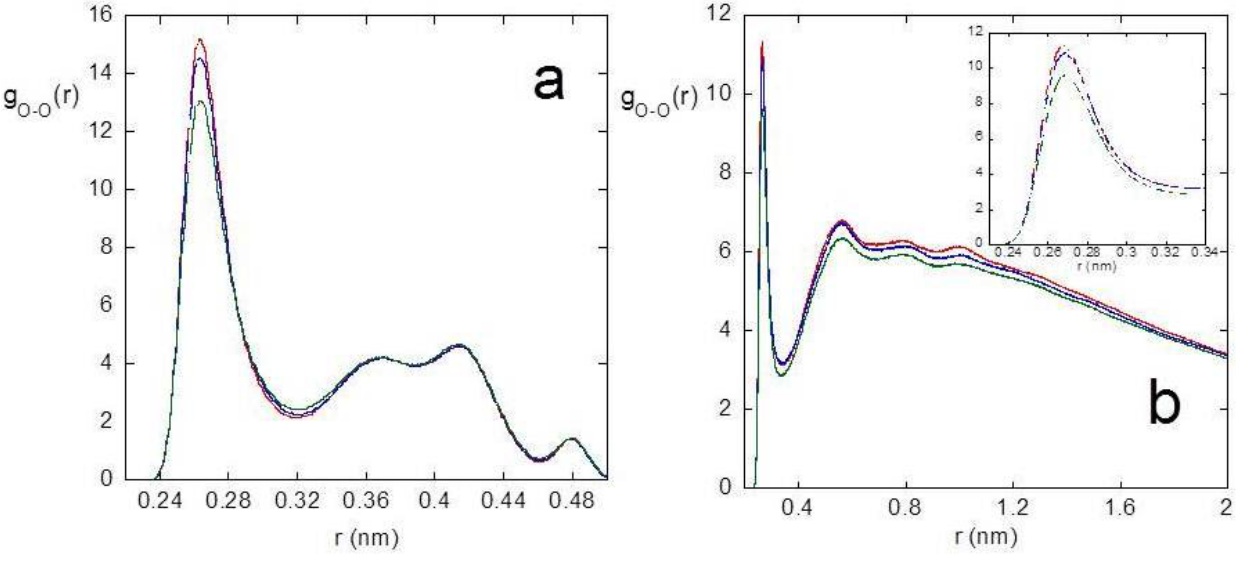
Figure 2. Radial distribution function between PVA oxygen atoms, (a) considering only oxygen pairs of near-neighboring residues, (b) considering only oxygen pairs separated by n residues, with n > 4. Red, blue and green curves refer to 283, 293 and 313 K, respectively. Average over the last ns